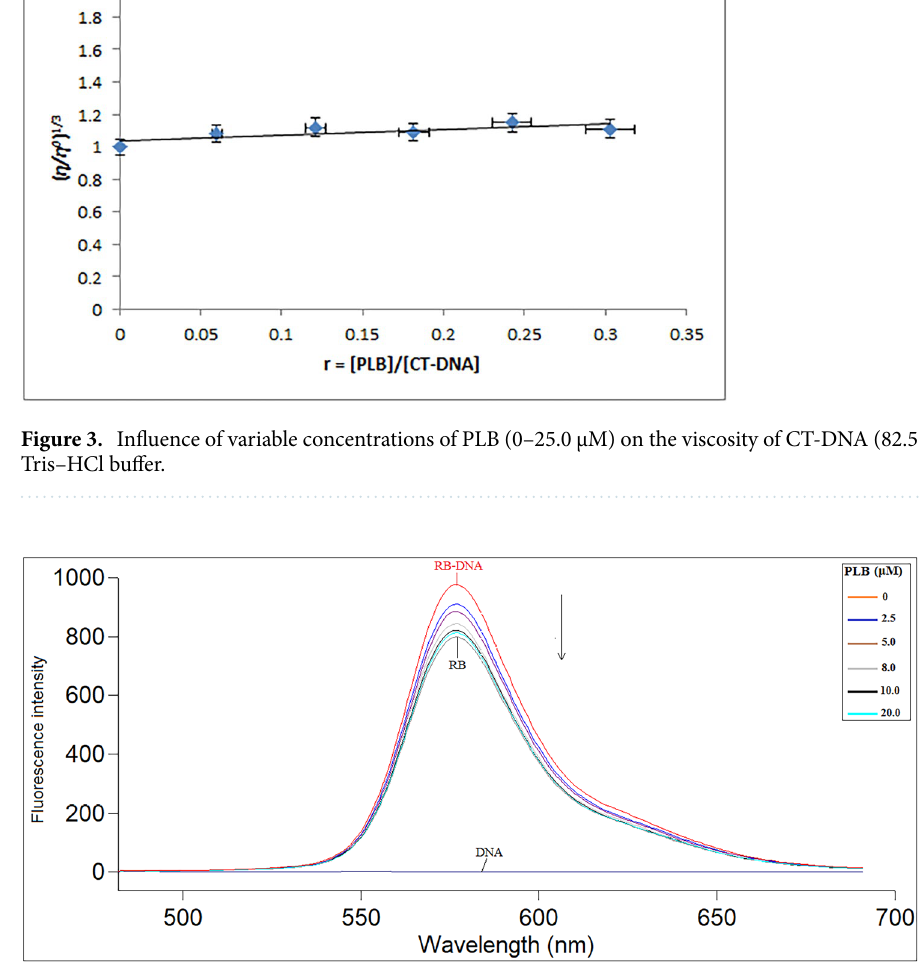
Figure 4. Fluorescence emission spectra of RB-CT-DNA complex at 298 K with or without PLB. C(CT-DNA): 57.0 μM; C(RB): 4.0 μM; C(PLB) (0–20.0 μM), (λ ex. /λ em. = 465/576